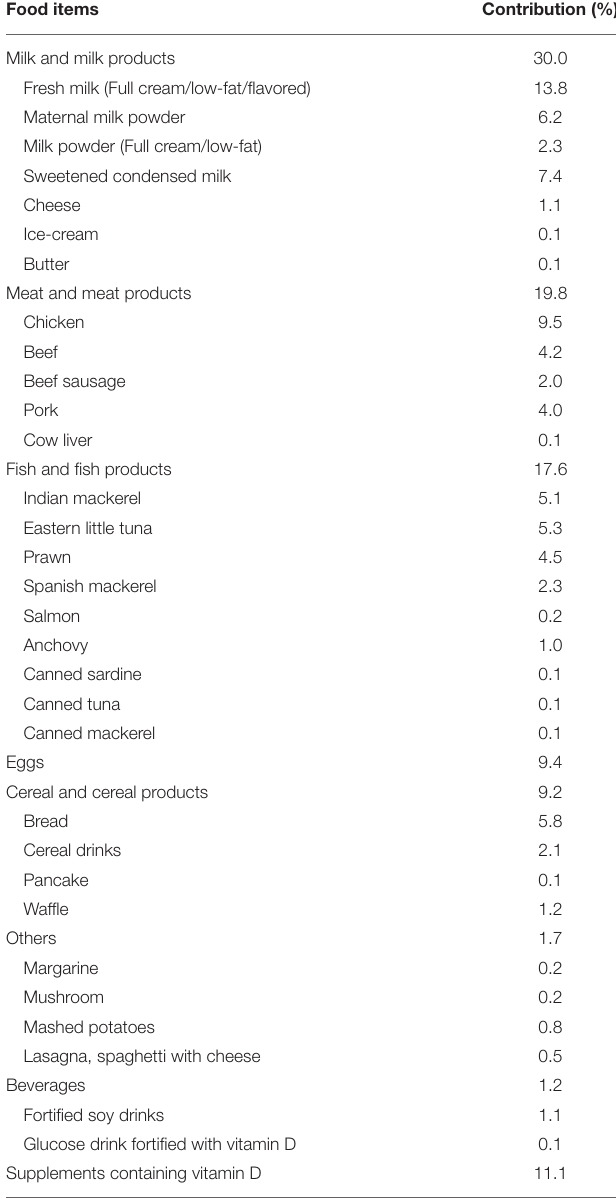
TABLE 2 | Contribution of food items toward the daily mean intake of vitamin D over the past 1 month among study participants ( n =